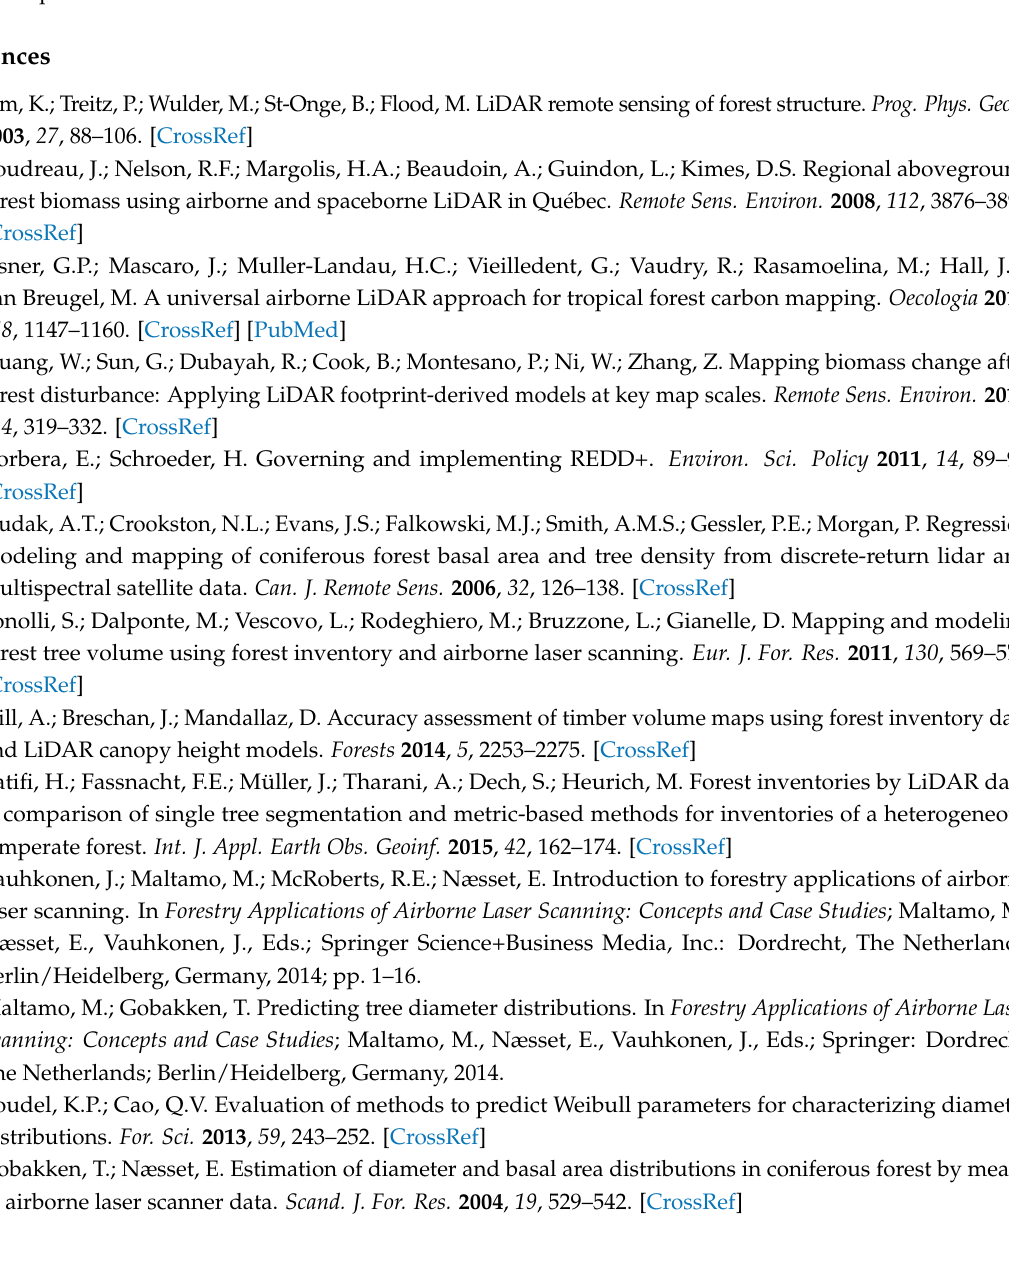
Figure S1: forest type map, Figure S2: example of joint relationships captured in priors, Figure S3: SDD predictions grouped according to basal area, Table S1: multivariate normal distributions used as